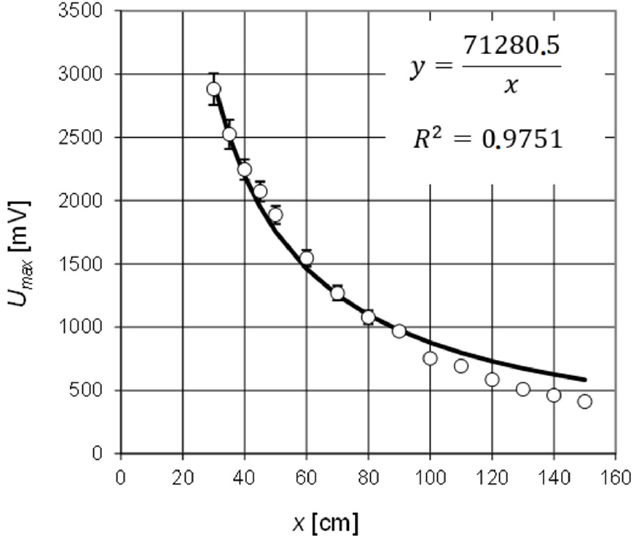
Figure 6. Dependence of the signal registered by the sensor on the distance from the source for the disc probe; the points mean the measurement; the curve means the function approximating the relationship, described by the formula as in the diagram; R 2 —coefficient of determination for the selected function.